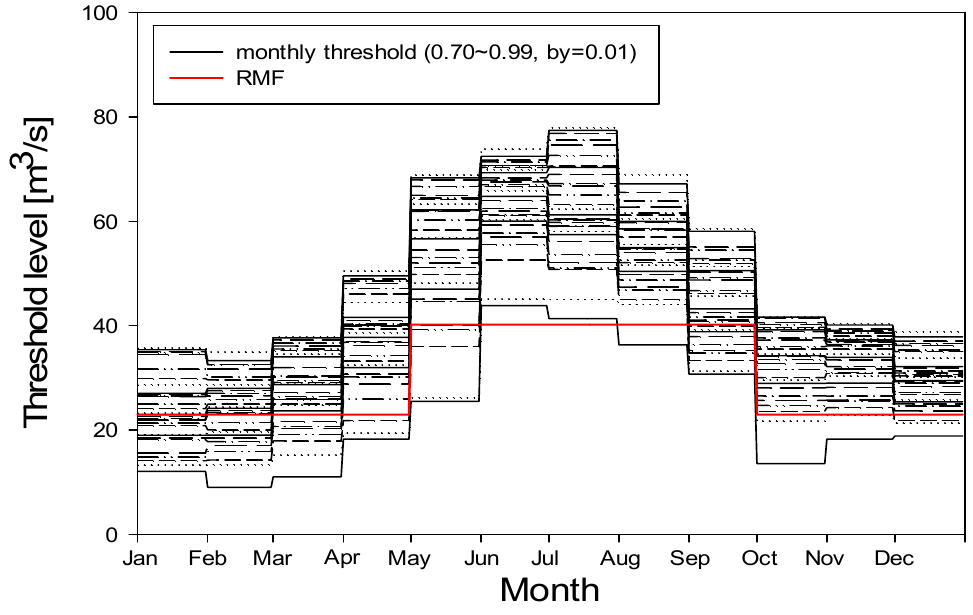
Figure 10. RMF and monthly threshold calculated by the FDC.